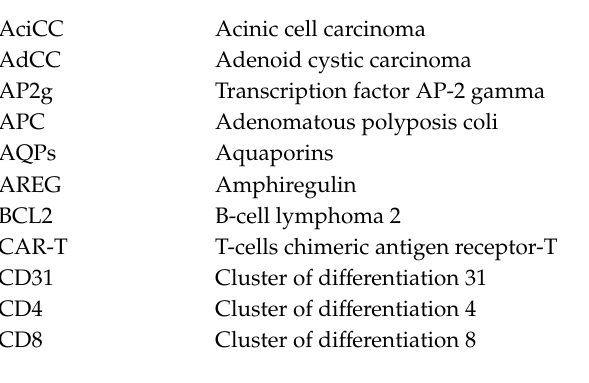
Table S1: Modified WHO classification list 2017 of SG tumors, including genes and molecular